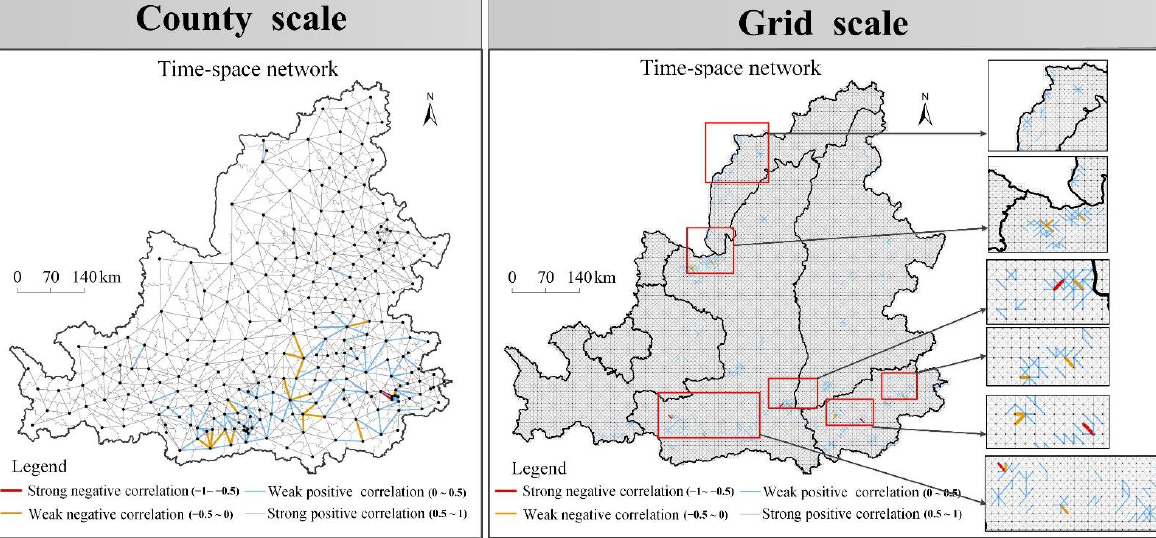
Figure 9. Spatio-temporal network of ecosystem health interaction in the MRYR.